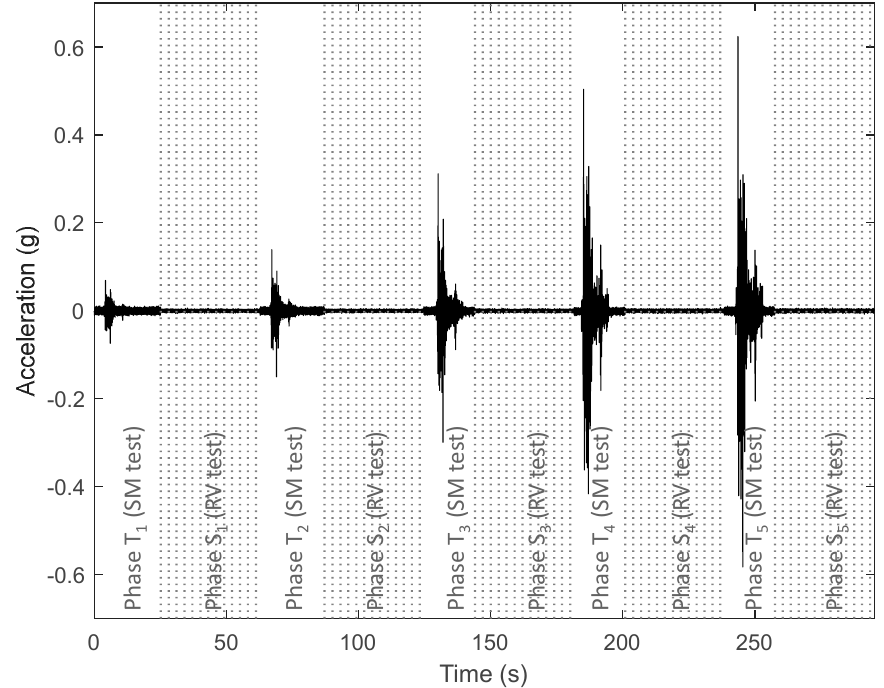
Figure 2. Sequence of 5 seismic inputs (strong motion SM and random vibration RV) of the scaled 1979 Montenegro earthquake.